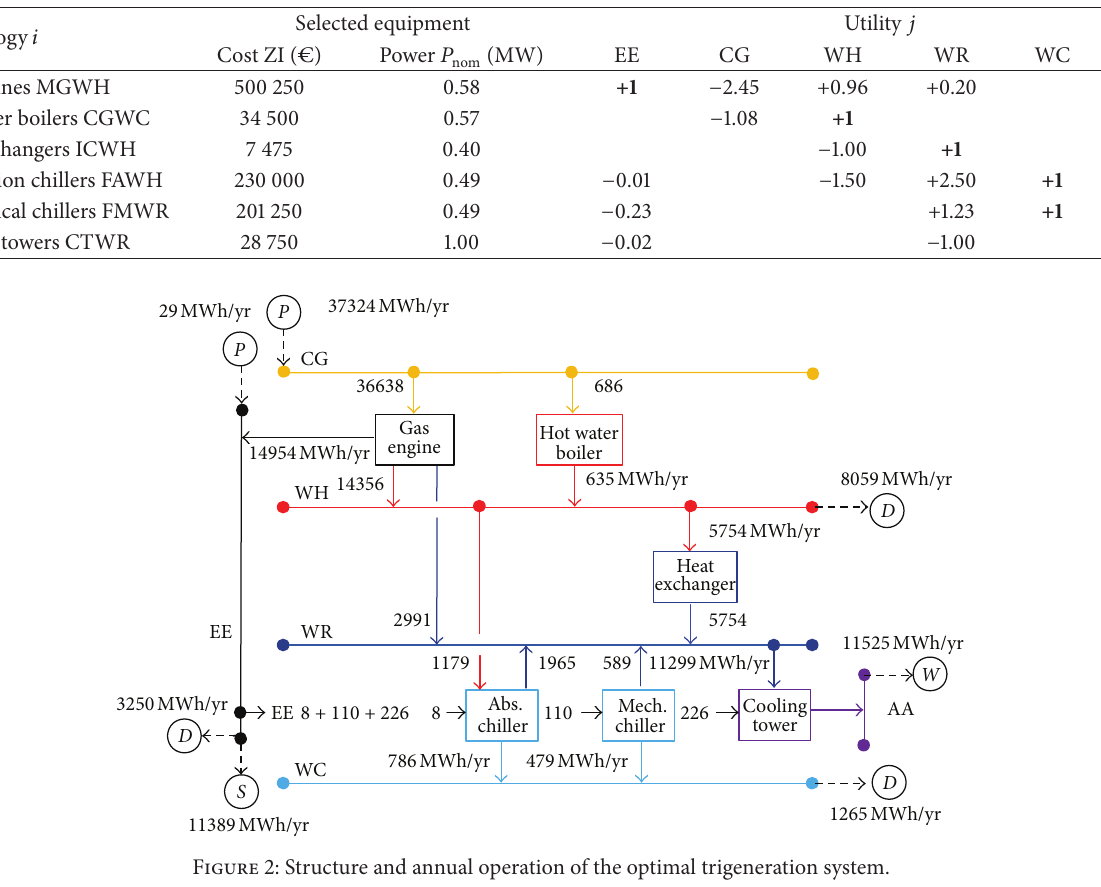
Table 1: Selected equipment and matrix of production coefficients.